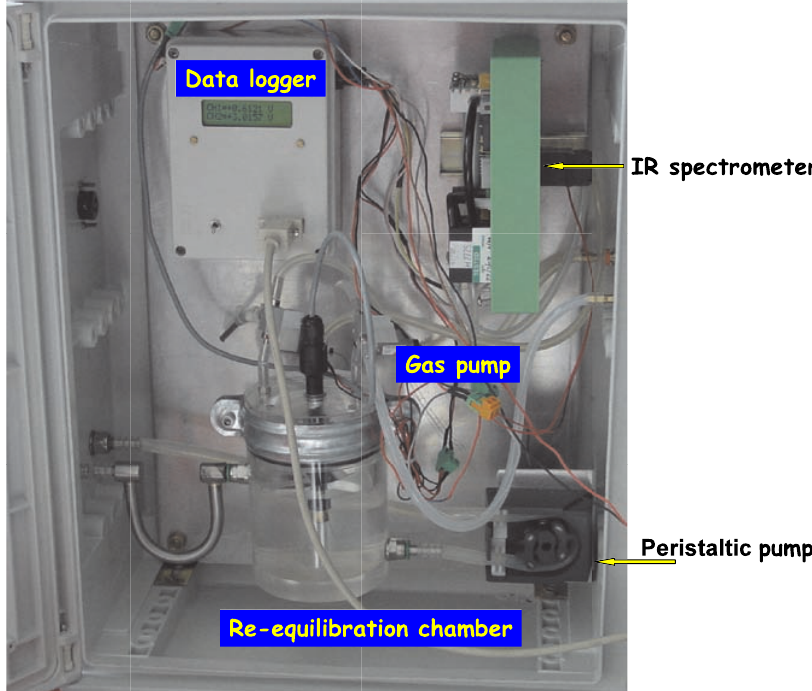
Figure 3. Photograph of the prototype of the continuous monitoring station for measuring dissolved CO